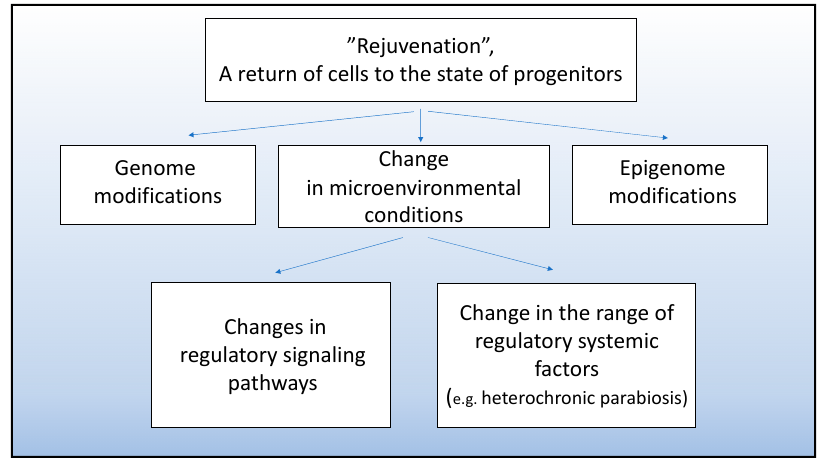
Figure 5. Approaches to obtaining cell populations with young phenotype and progenitor proper- ties.